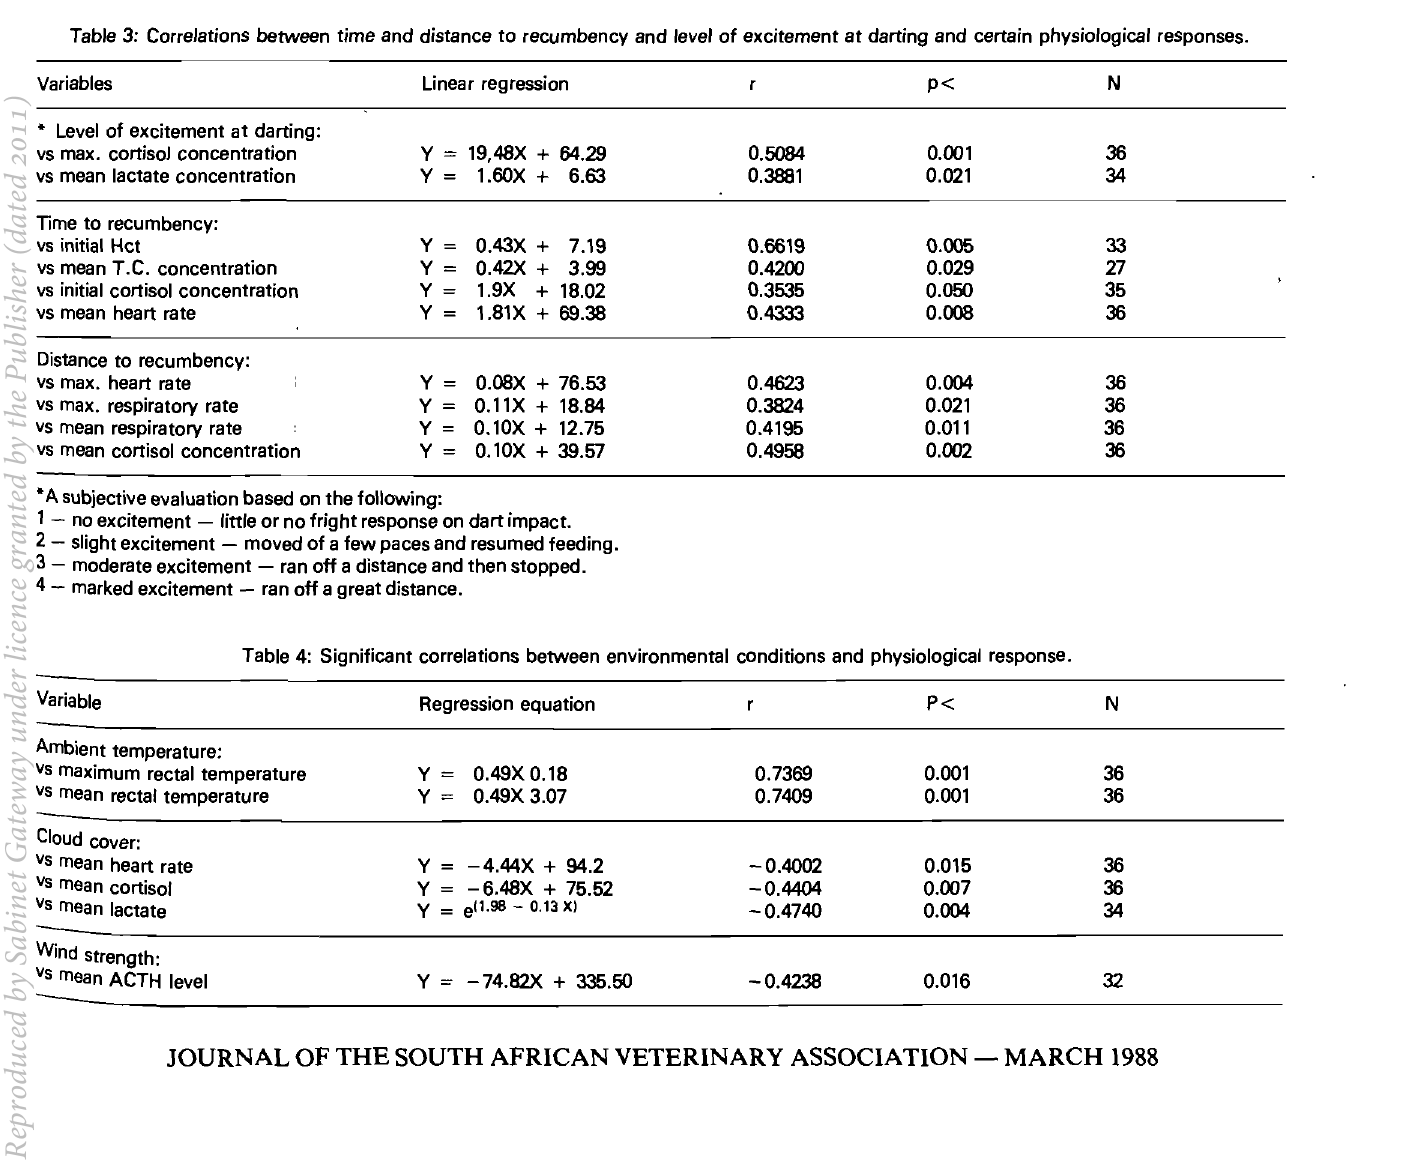
Table 3: Correlations between time and distance to recumbency and level of excitement at darting and certain physiological responses. Variables Linear regression